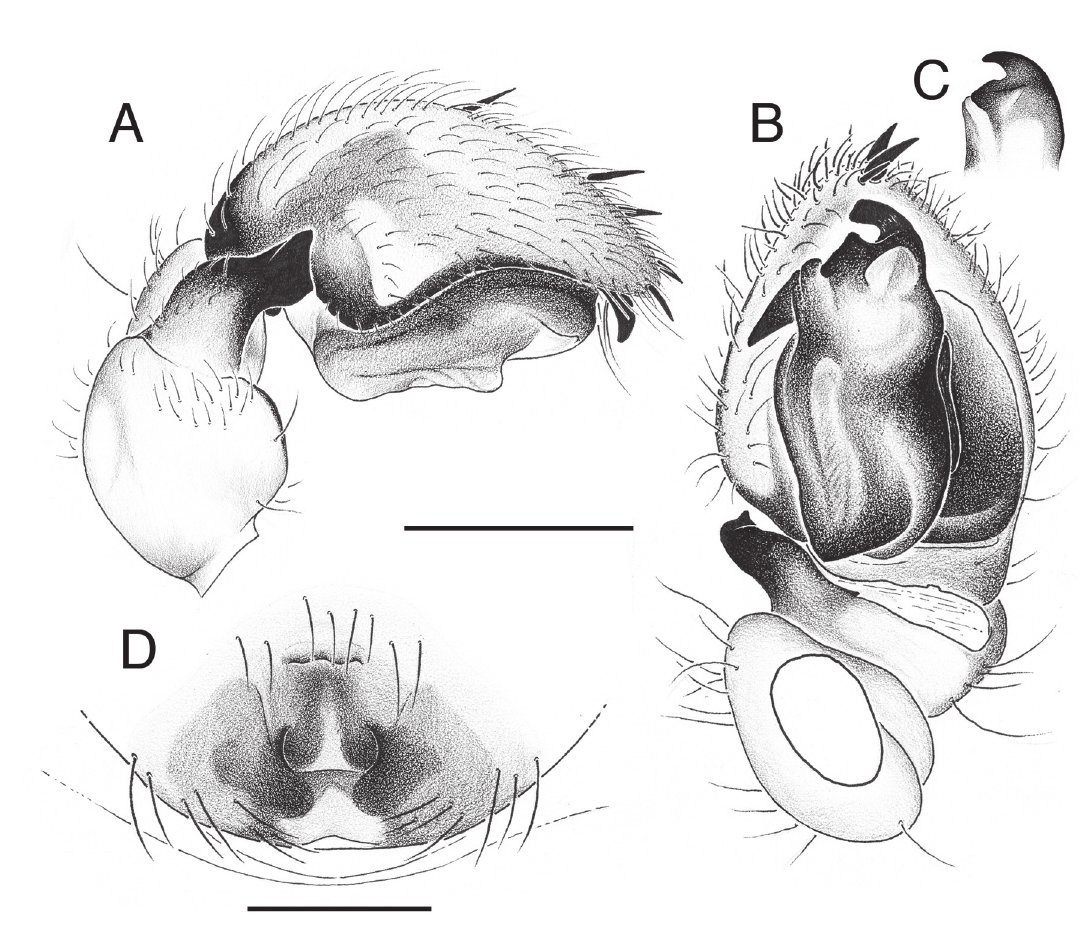
Fig. 10. Palindroma avonova gen. et sp. nov. A–B. Holotype, ♂. C. Paratype, ♂, from Marimba Forest. D. ♀ from Maringa forest. A . ♂, palp, retrolateral view. B . Idem, ventral view. C . Palp detail of paratype, enbolus, ventral view. D . ♀, epigyne, ventral view. Scale bars = 0.5